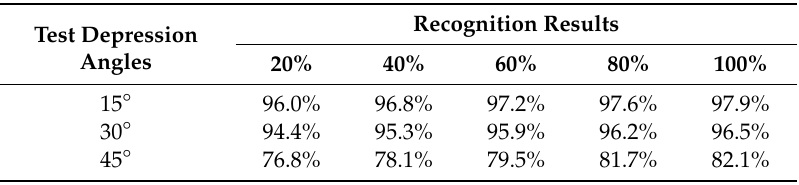
Table 11. Recognition results with di ff erent small simulated